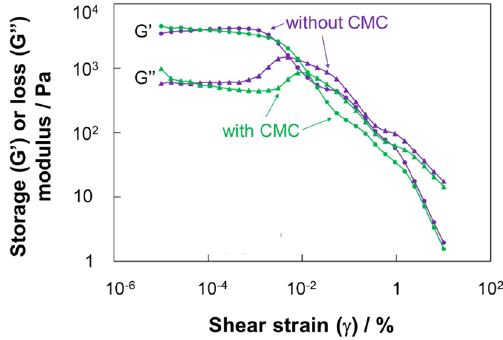
Figure 1. Storage and loss modulus of MgOC inks with or without CMC as a function of shear strain. Angular frequency: 1.0 rad s −1 ; temperature 25 °C. Circles: storage modulus (G’); triangles: loss modulus (G’’); green: MgOC ink containing CMC; violet: MgOC ink without CMC.